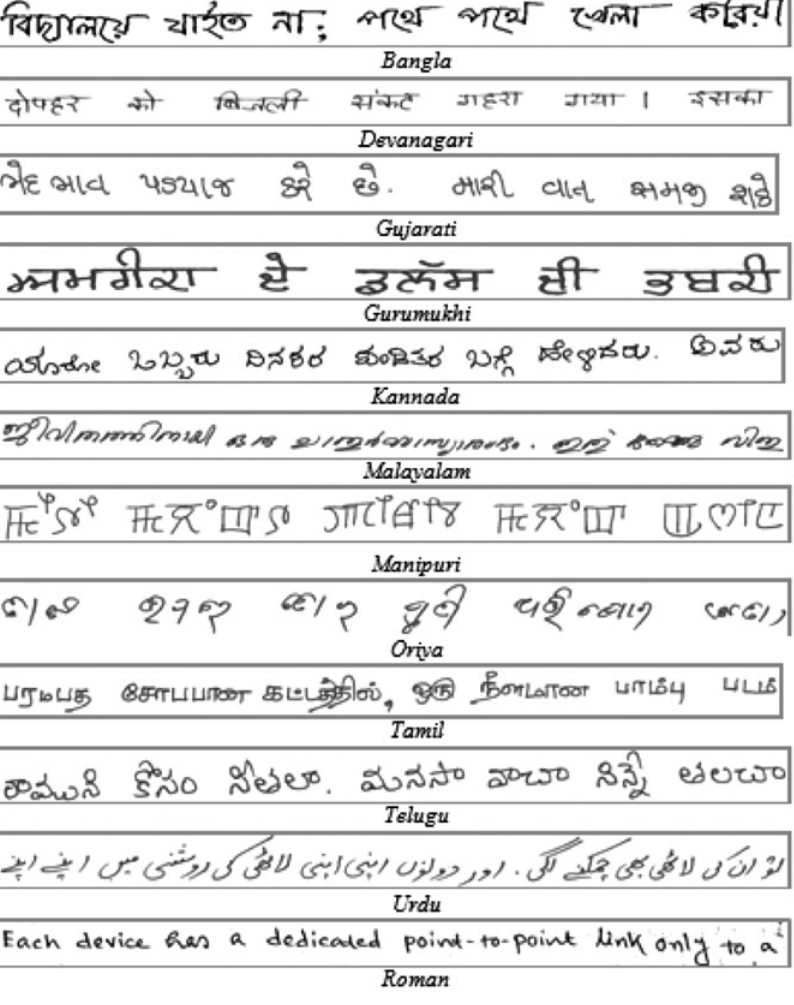
are collected from different sources on request. Participants of this data collection drive are asked to write a few text lines inside A-4-size pages. No other restrictions are imposed regarding the content of the textual materials. Handwritten text lines were written in 12 official scripts of India. The document pages are digitized at 300 dpi resolution and stored as gray tone images. The scanned images may contain noisy pixels, which are removed by applying a Gaussian filter [10]. Sample snapshots of text-line images written in 12 different scripts are shown in Figure 6. Finally, 3600 handwritten text-line images are created, with exactly 300 text lines per script. For the application of the DS theory at word level script identification, the words are cropped automati- cally from the text-line images. After that, the words having a length of less than three candidate characters are excluded. This is because a less number of characters present in the text words may not be useful for identifying the scripts. Hence, a set of 500 text words per script is selected in performing the experiment at word level. Figure 7 shows samples of the word images written in 12 different scripts.